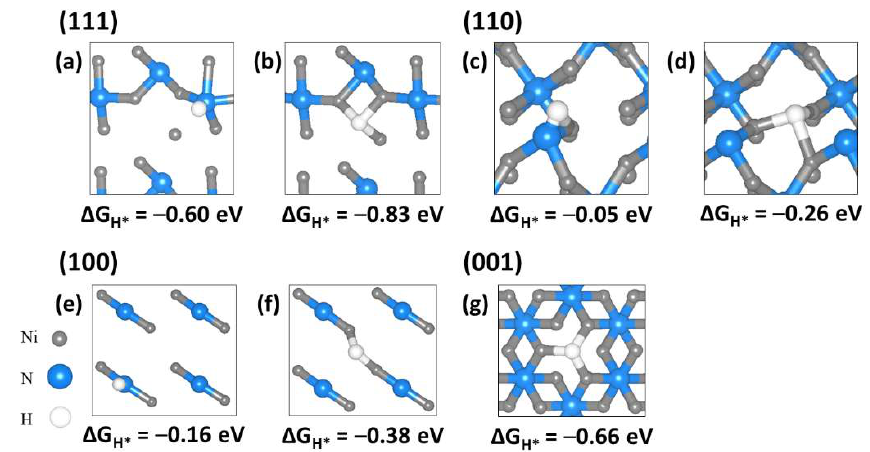
Figure 6. Two most optimal free energy of hydrogen adsorption ( ∆ G H *) structures on each of the Ni 3 N surfaces. Where ( a , b ) are for the (111) surface, ( c , d ) for the (110), ( e , f ) for the (100), and ( g ) for the (001) surface.